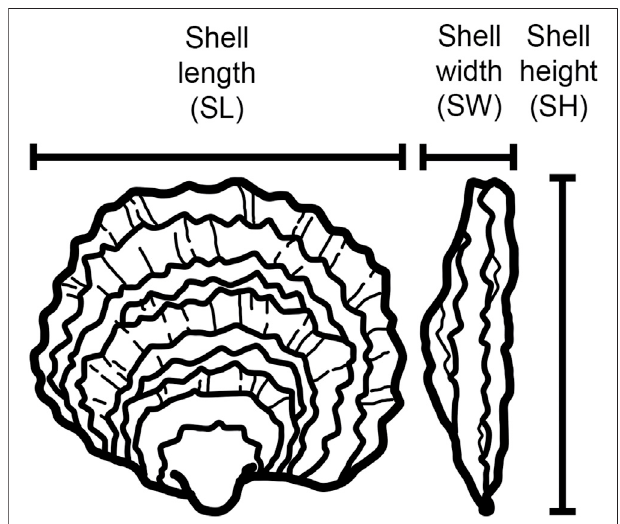
FIGURE 1 | Nomenclature of the growth-related morphometric traits measured in this